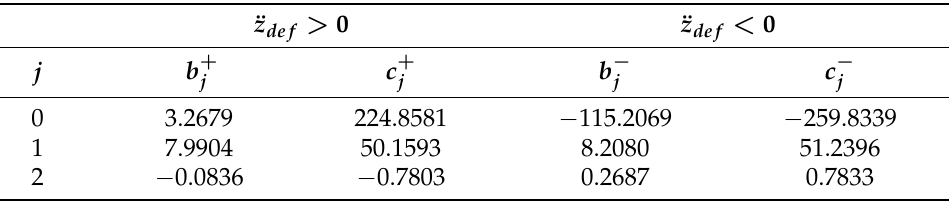
Table 1. Inverse polynomial model parameters for positive and negative acceleration of the suspen- sion deflection (copyright AMCA (2019), reproduced from [17]). ¨ z def > 0 ¨ z def <